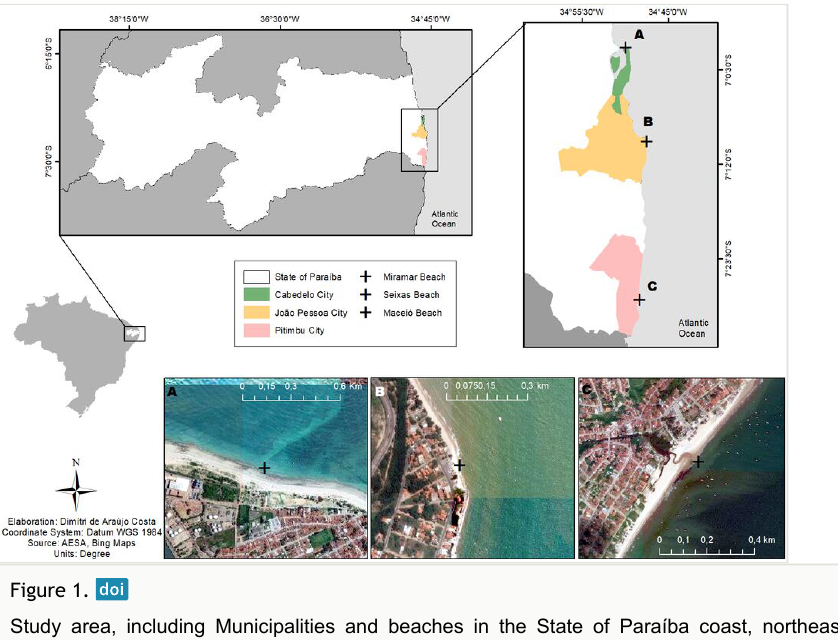
Figure 1. Study area, including Municipalities and beaches in the State of Paraíba coast, northeast Brazil. A. Miramar Beach (1.5 m: 6°57'51"S/34°50'01"W; 4.0 m: 6º57'50"S/34º50'01"W); B. Seixas Beach (1.5 m: 7°09'18"S/34°47'35"W; 4.0 m: 7°09'18"S; 34°47'33"W); C. Maceió Beach (1.5 m: 7°28'34"S/34°48'27"W; 4.0 m: